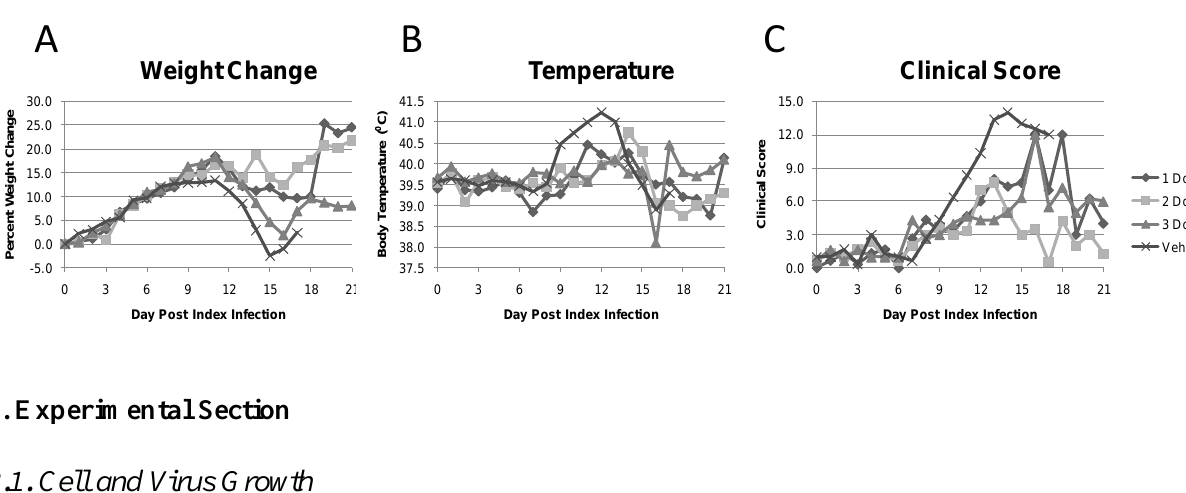
Figure 8. Aerosol infected animals treated beginning at the appearance of secondary lesions. Groups of 3 animals were treated with CMX001 1, 2 or 3 times every other day beginning at the appearance of secondary lesions in the ears. Animals were dosed at concentrations and schedules as outlined in Table 3. (A) Average weight change over time for each group. Negative values represent weight loss. (B) Average body temperatures over